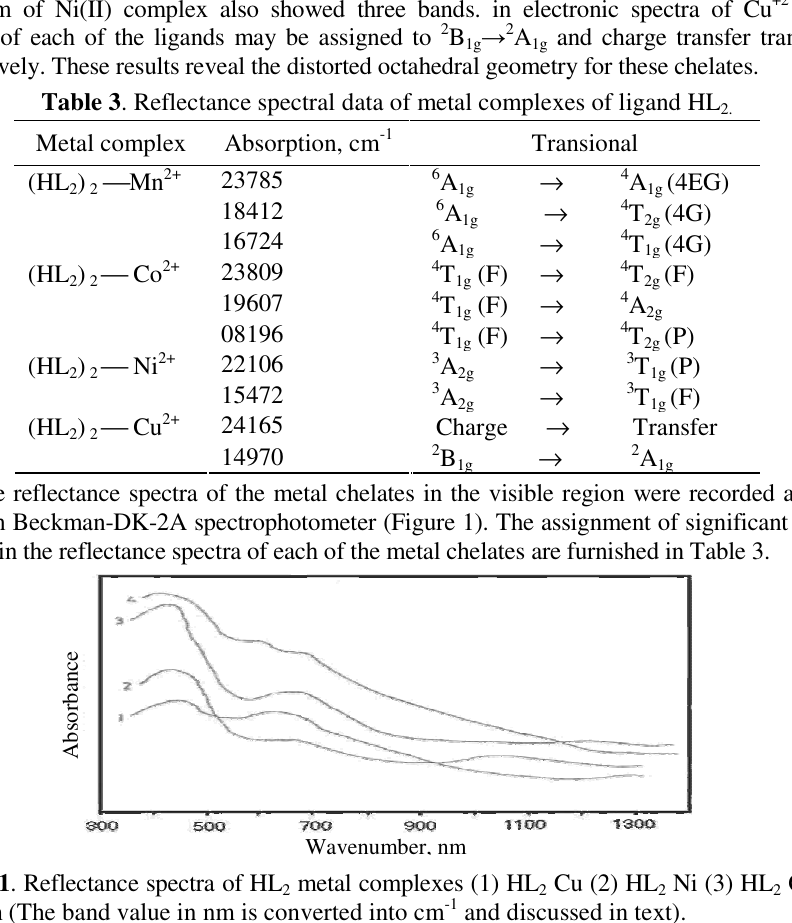
Cu (2) HL Ni (3) HL Co (4) 2 2 2